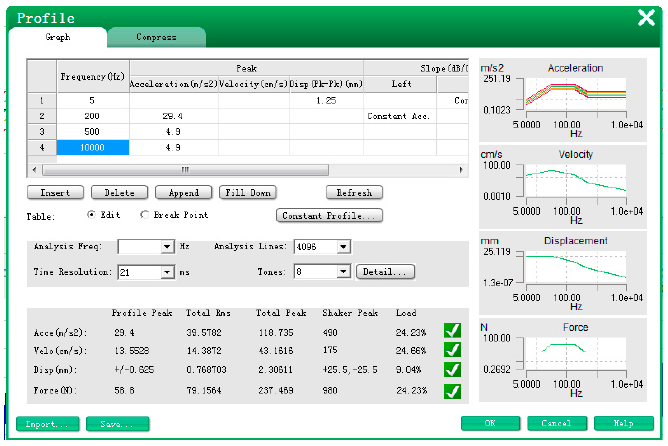
Figure 5. The spectrum settings of composite excitation.